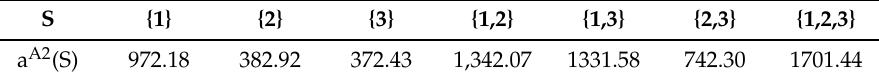
Table 25. NPV of the total running cost for implementation of alternative A2.